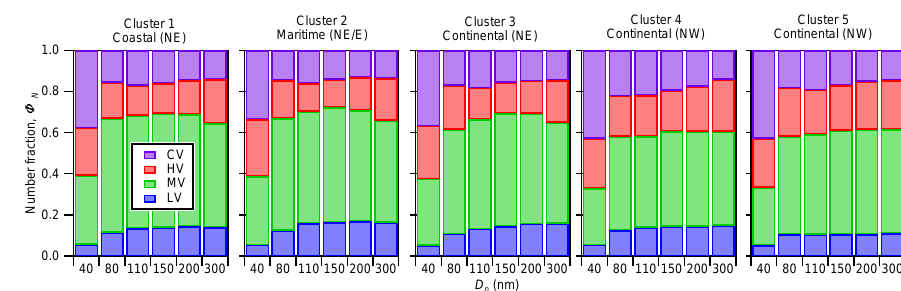
Figure 8. Average number fractions of CV, HV, MV and LV in clusters 1 to 5 at different selected diameters. Table 3. Summary of concentrations of PM 2 . 5 , OC, EC and the OC-to-EC ratio (OC / EC ratio) in the five clusters. Cluster Coastal